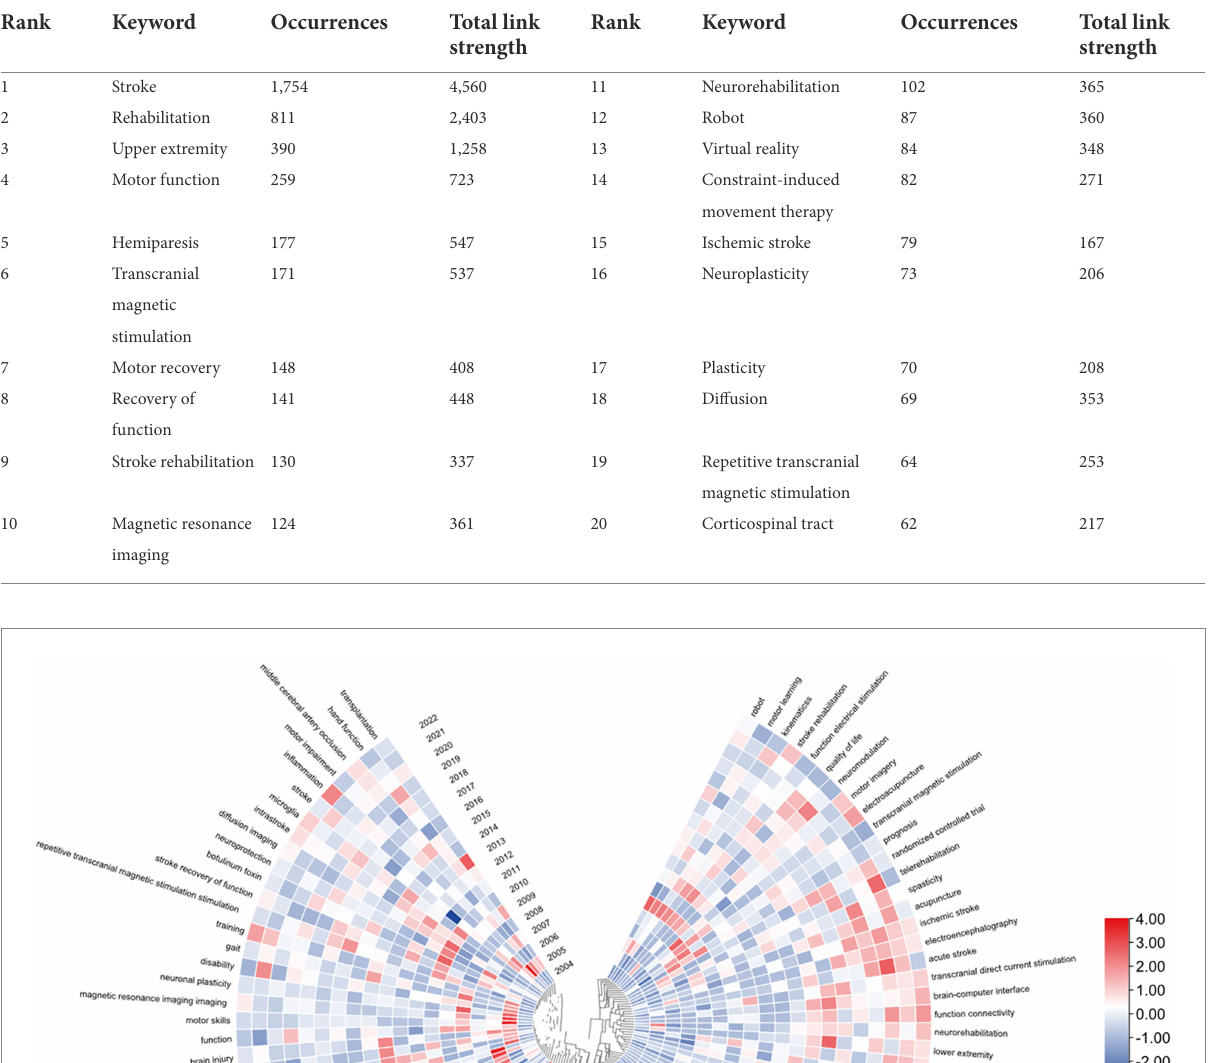
TABLE 5 Top 20 keywords related to stroke motor function rehabilitation.